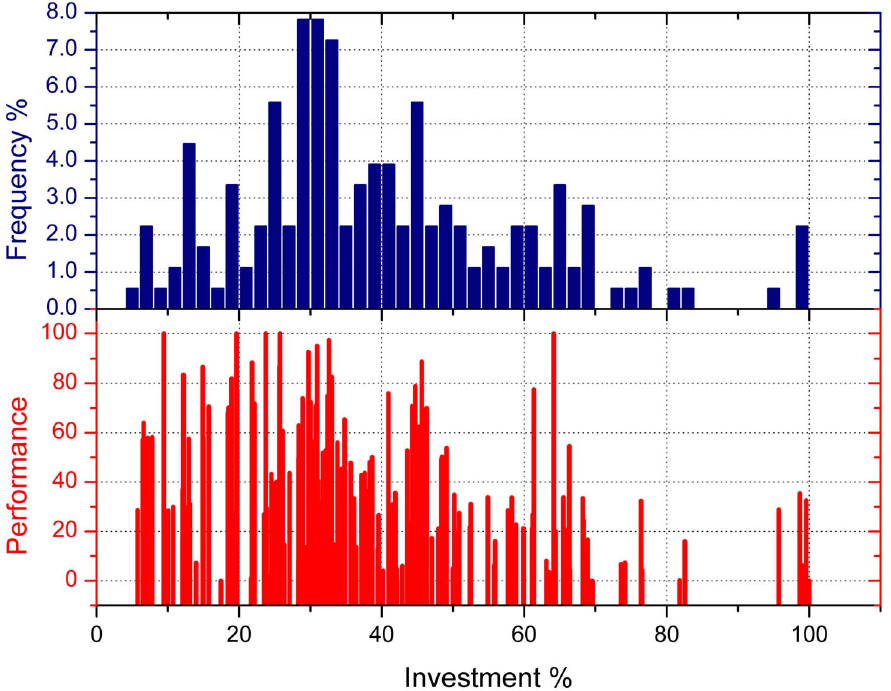
Figure 5. The effect of risk preference on the players’ wealth in all the experiments. The blue bar means the frequency counting number percentage of the investment proportion which lies in the certain range on the X axis; the red line means the performance score of a certain player in a certain experiment, in the scale of 0 to 100. (In order to make the results comparable, for each experiment, the highest wealth number W h is treated as 100, and another score of a certain wealth number W n is calculated as 100 (cid:2) W n = W h ).